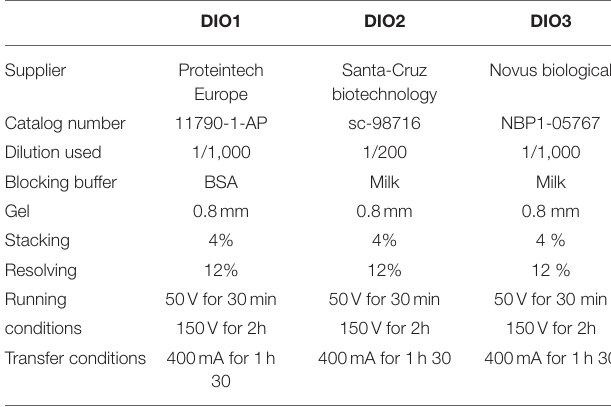
TABLE 1 | Primary antibodies and specific conditions used for analysis of DIO protein